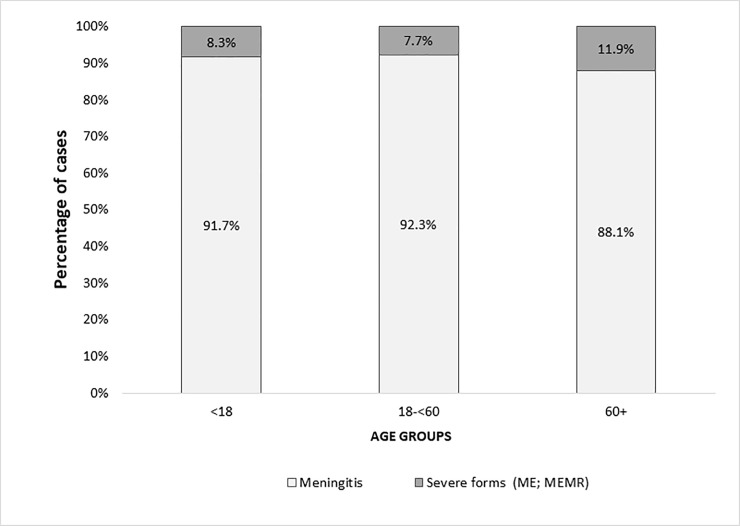
TBE clinical forms by age groups.